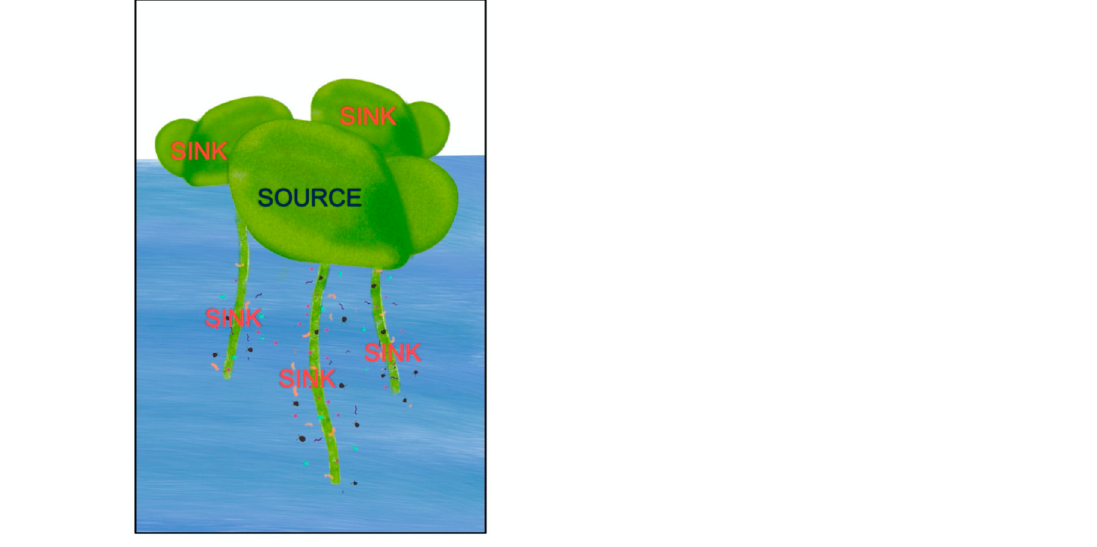
Figure 11. Schematic depiction of a Lemna colony consisting of a mother frond as the source of photosynthate for expanding daughter fronds as well as for the rhizosphere microbiome as sinks of photosynthate.